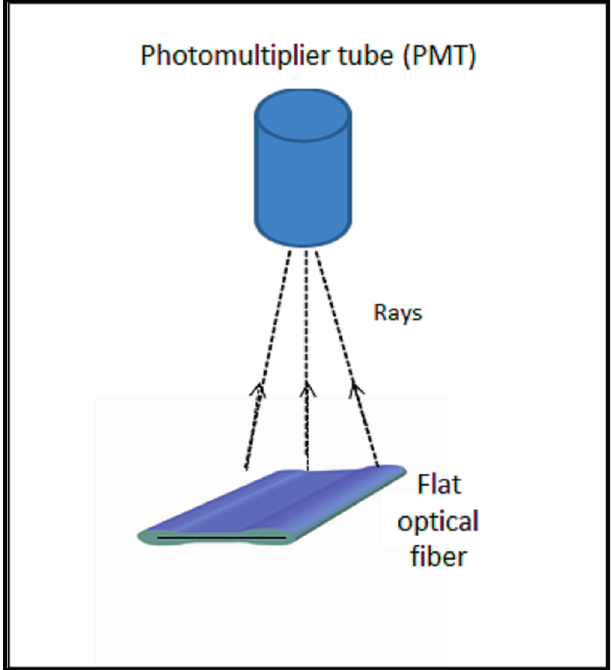
Figure 3 . Dose response of Ge-doped optical fibers of cross-section dimensions 85 × 270 µm, 100 × 350 µm, 165 × 620 µm and 200 × 750 µm compared to that of TLD100, provided together with the standard error of the mean. The dotted lines are least square fits to the data, obtaining respective correlation coefficients of 0.983, 0.951, 0.949, 0.983, and 0.996. (Note: in some cases the error bars are smaller than the data points).